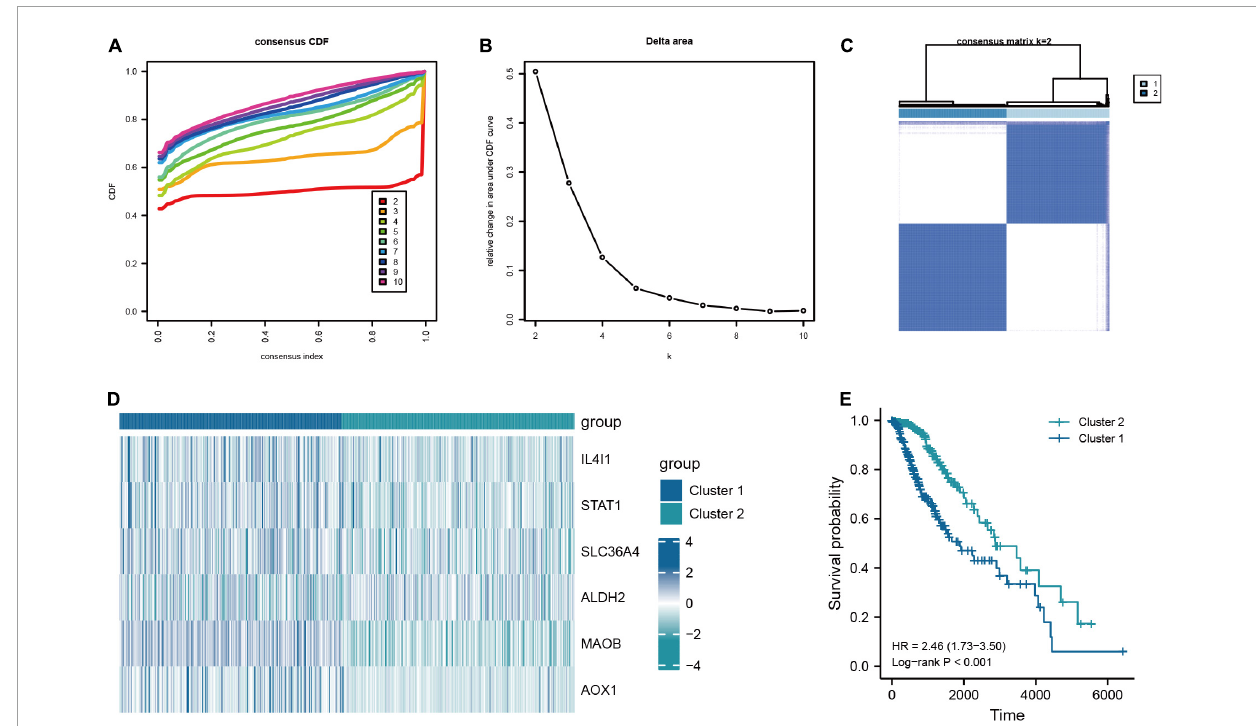
FIGURE6 Consensus clustering analysis based on the key TRGs in LGG. (A) CDF curve distribution for consensus clustering. (B) Relative change in area under CDF curve when k = 2–10. (C) Unsupervised clustering analysis based on the key TRGs. (D) Expression distribution of six key TRGs in cluster 1 and cluster 2. (E) The Kaplan-Meier plot comparing the cluster 1 and cluster 2 in